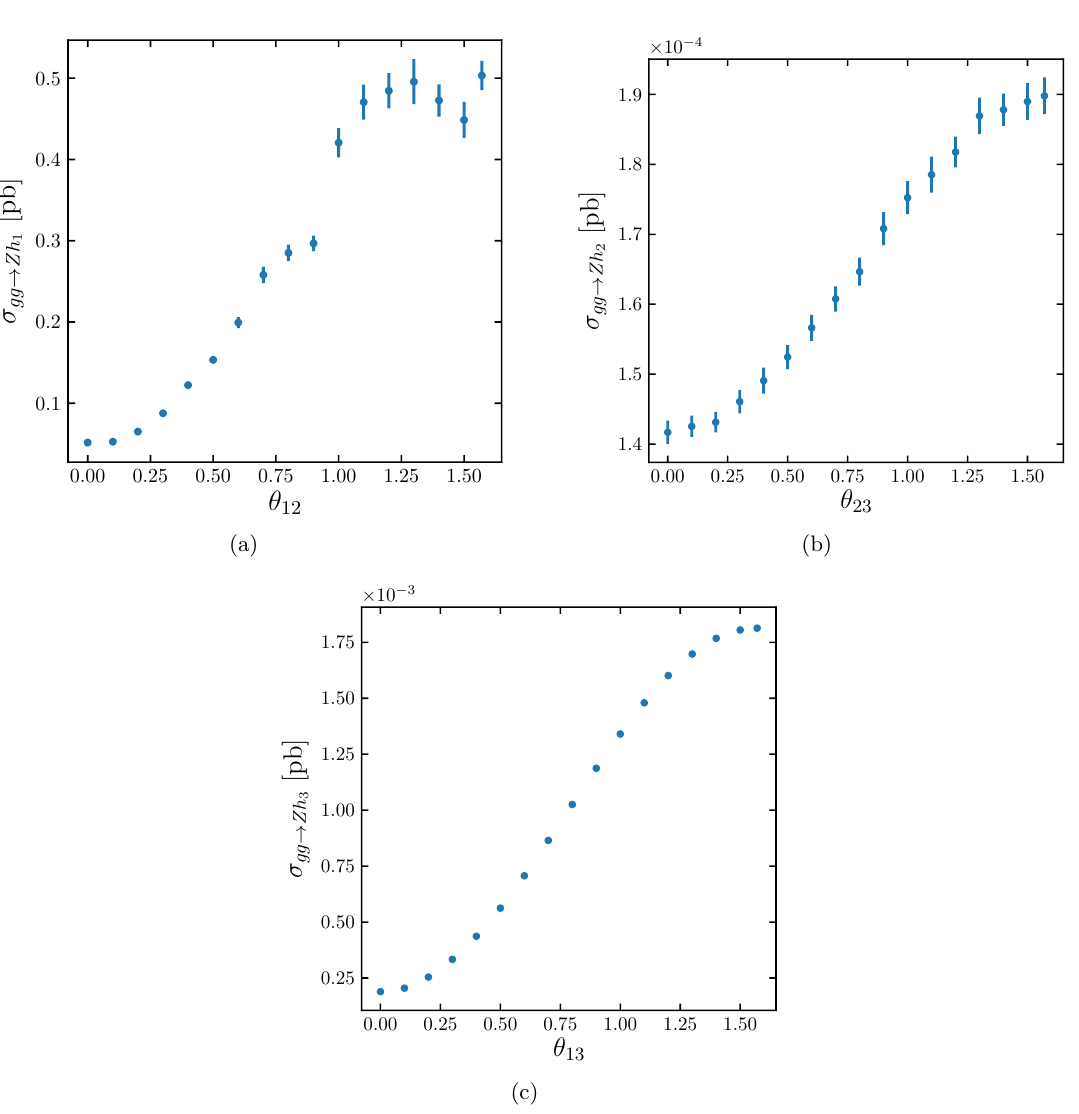
Figure 9 . The gg ! Z(cid:30) component of Zh production including CP mixing for the production of h 1 , h 2 , and h 3 . The left end of each plot corresponds, from ( a ){( c ), to the production of h , H , and A within a type-II 2HDM with tan (cid:12) = 20 and sin( (cid:12) (cid:0) (cid:11) ) = 1. The Higgs masses are set to m h = 125 GeV and m h = m h = 300 1 2 3